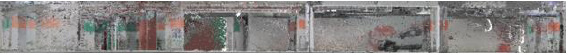
Figure 6. Coloured point clouds fused by camera image and laser scanner point clouds.